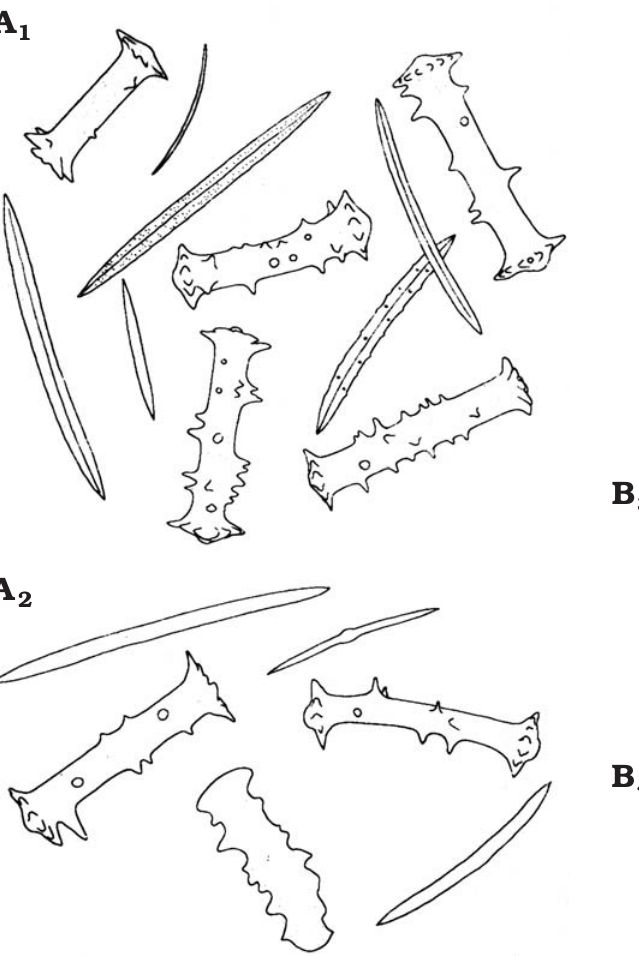
Horizon : Miocene. Locality : Lacustrine deposit at Oviatt Creek, northern Idaho, USA.